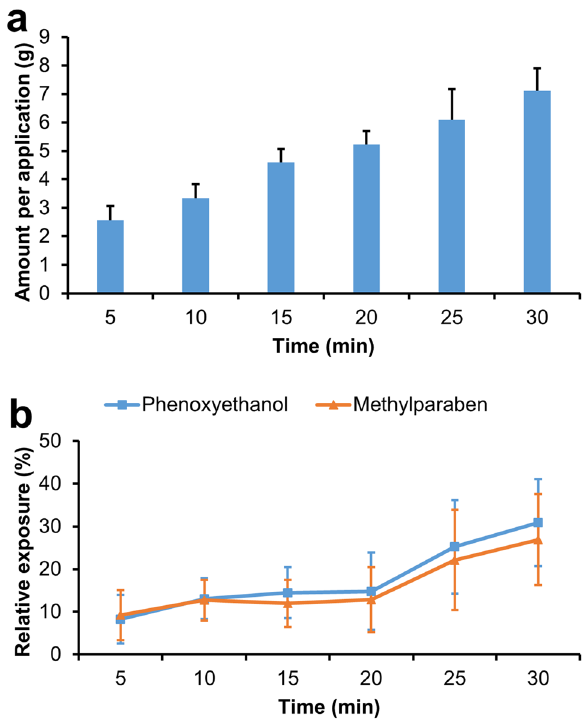
Figure 1. The time trends of amount per application of facial sheet mask and the relative exposure amount to non-VOCs represented by phenoxyethanol and methylparaben. A subpopulation of the subjects was asked to apply the masks for 5, 10, 15, 20, 25, and 30 min respectively and the residues were collected for HPLC analysis and were compared to the amount measured in the masks of same batch and size before use. The amount per application at different time of duration was shown in ( a ); and relative exposure to phenoxyethanol and methylparaben was calculated and expressed as percentage of the difference between the content after use and before use over their initial content before use and was shown in ( b ). Data was shown as mean ±